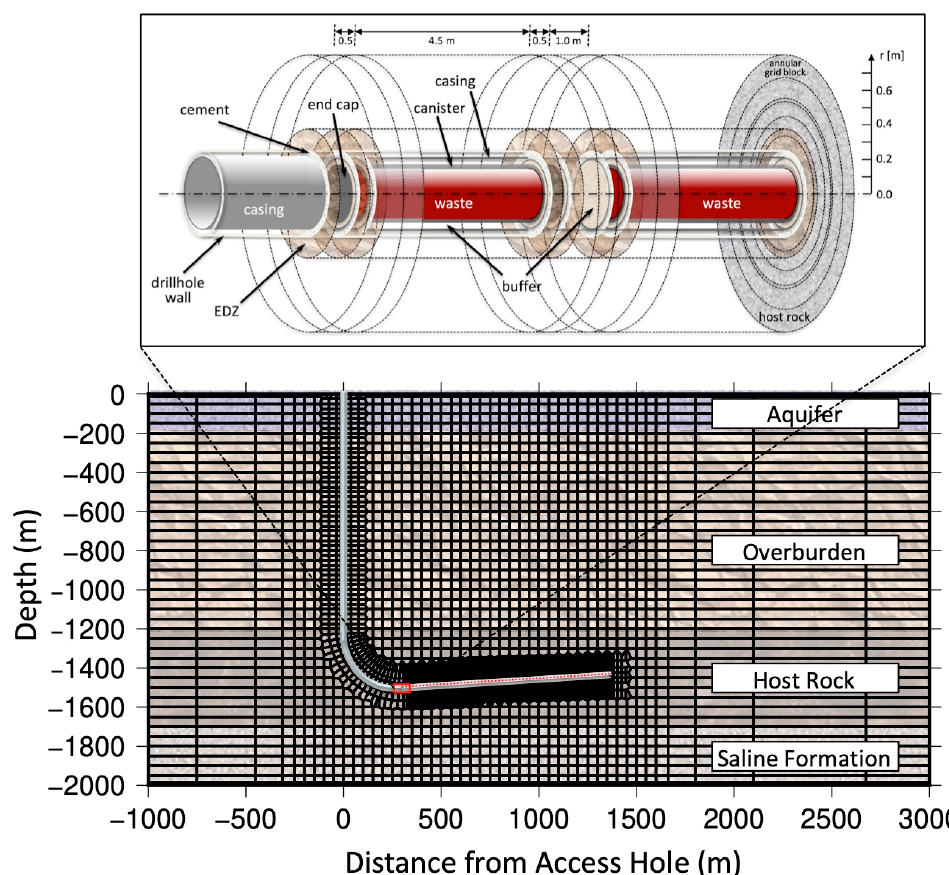
Figure 3. Computational grid: (top) excerpt of the radial–axial grid of the near-field model, which follows the trajectory of the directionally drilled borehole and is embedded in the three-dimensional Voronoi grid of the geosphere model (bottom). A total of 153 waste canisters are individually represented in the sub-horizontal disposal section, which is at a depth of 1.5 km. A detailed description of the grid can be found in [46] .